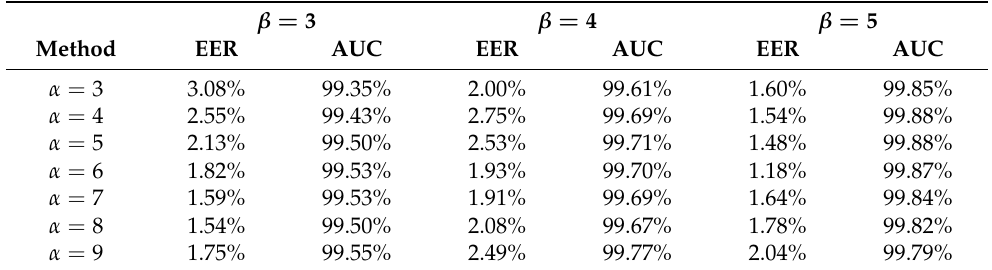
Table 1. 3D Palmprint: EER and AUC values for all curves reported in Figure